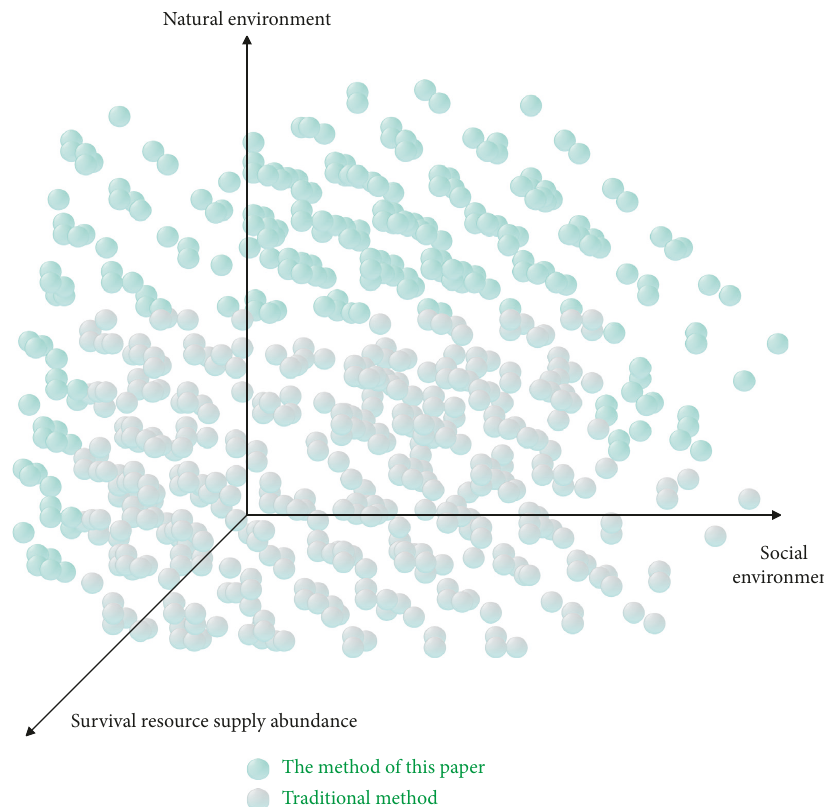
Figure 8: Cluster analysis of the effectiveness of the method proposed in this